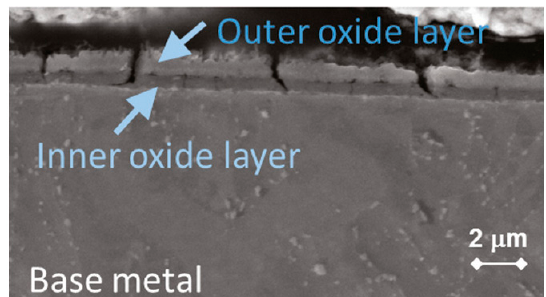
Figure 2. Double-layer oxide scale developed and braked in T91 steel under constant extension rate test in Pb at 400 °C, showing many superficial cracks in the oxide; SEM-secondary electrons image from [28].